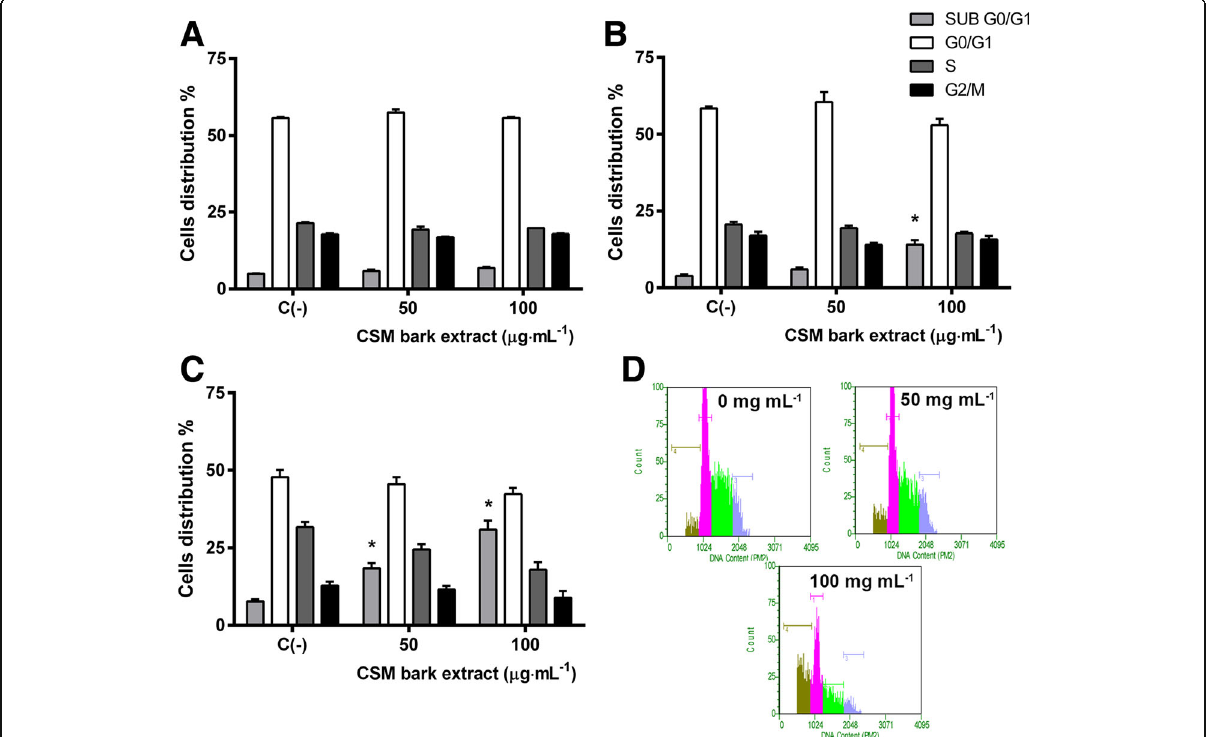
Fig. 4 Effect of CSM bark extract treatment on cell-cycle. Jurkat cells were treated with extract for 24 h ( a ), 48 h ( b ), 72 h ( c ) and representative histograms of cell-cycle analysis at 72 h treatment ( d ). Cellular distribution in the different phases was evaluated by FCM as described in Methods. Each bar represents the mean ± SEM of five independent experiments. Data were analyzed by repeated ANOVA followed by Bonferroni post-test. * p < 0.05 vs control sub G 0 /G